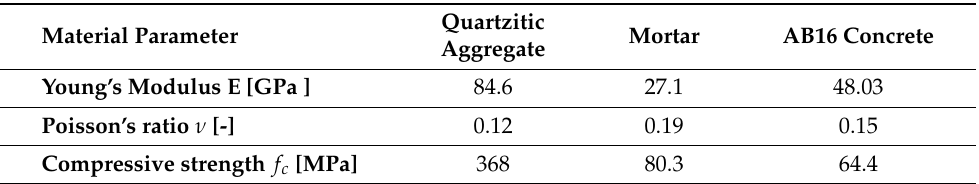
Table 3. Young’s Modulus, Poisson’s ratio, and the compressive strength of the quartzitic aggregates, mortar, and the concrete with an AB16 grading curve.